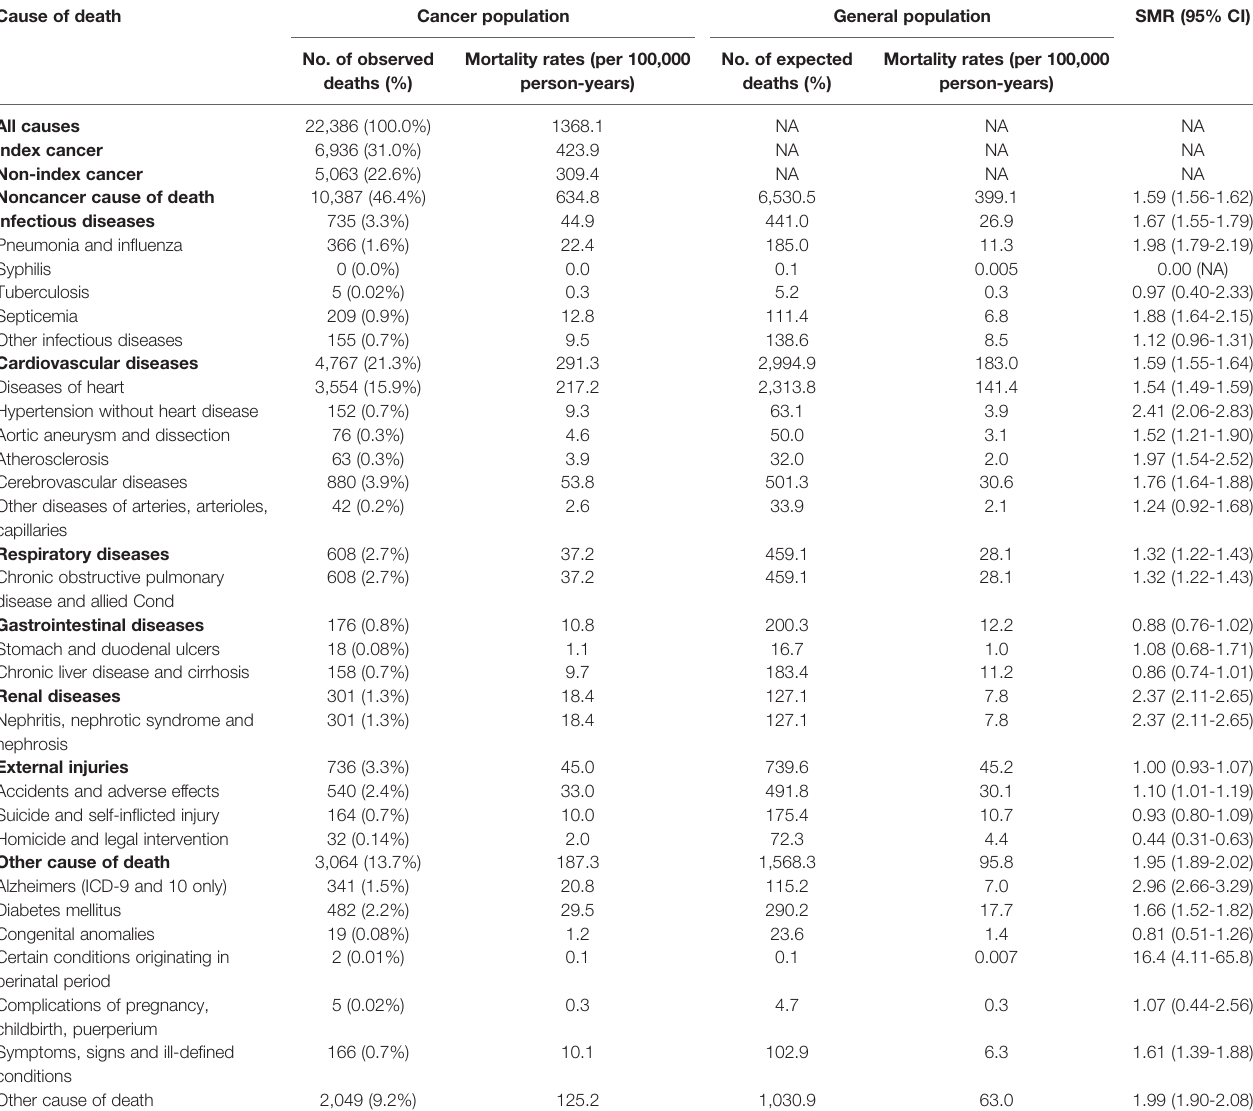
TABLE 2 | Cause of death among patients with thyroid cancer in the SEER 18 program. Cause of death Cancer population